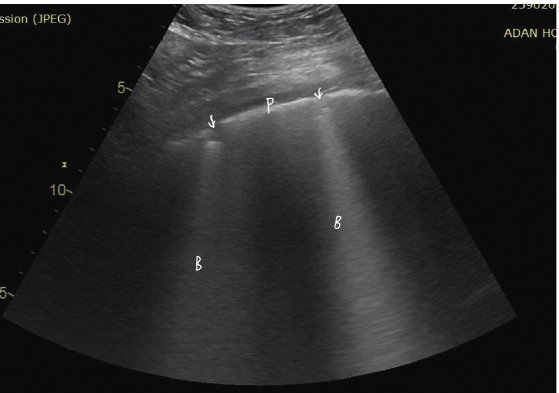
Figure 3: Separated B-lines with irregular pleura. P, pleura; B, B-lines; arrow, subpleural